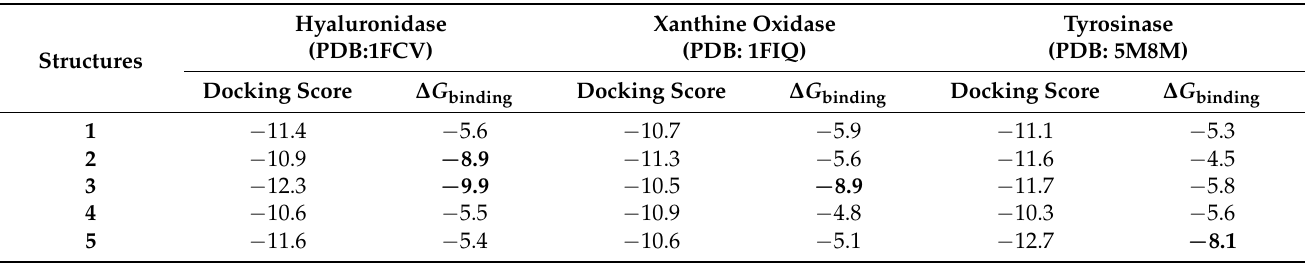
Table 2. Docking scores and calculated ∆ G binding values (expressed as kcal/mol) of compounds 1 – 5 with hyaluronidase, xanthine oxidase and tyrosinase enzymes.